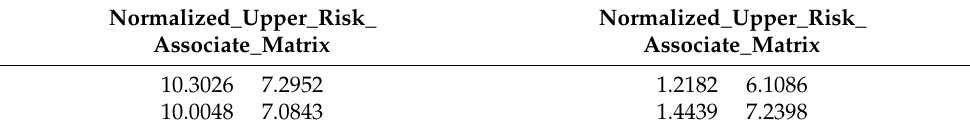
Table 14. Normalized risk factor matrix.